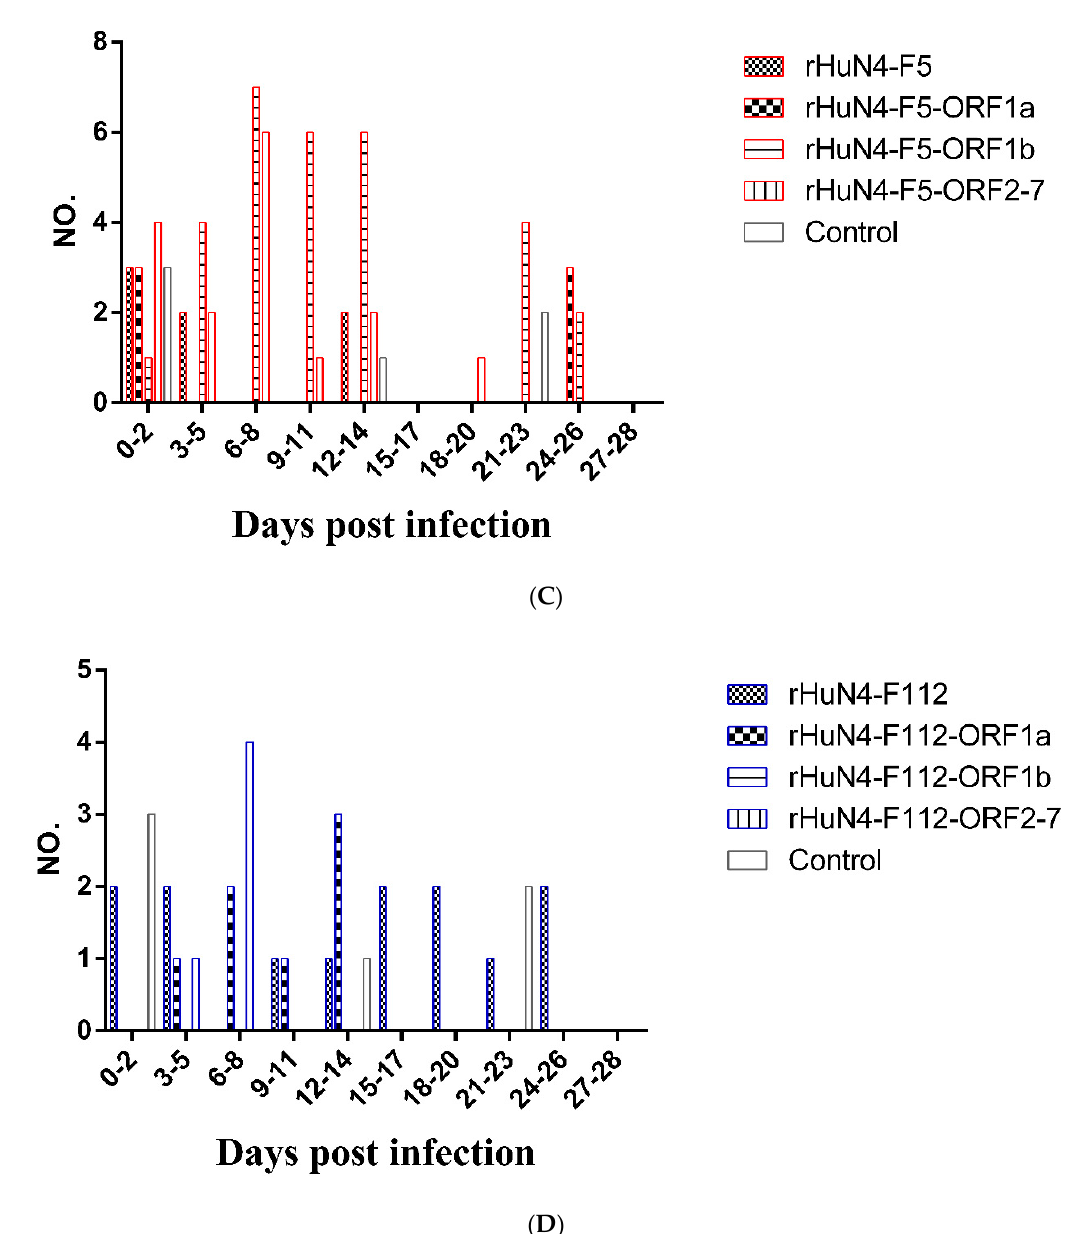
Figure 3. Rectal temperature after infection. ( A ) Mean rectal temperature of each group after infection. ( B ) Amount case of rectal temperature equal or higher than 40.5 °C of each group. ( C ) Amount case of rectal temperature higher than 40 °C and lower than 40.5 °C of groups which infected with HuN4-F5 backbone chimeric viruses. ( D ) Amount case of rectal temperature higher than 40 °C and lower than 40.5 °C of groups which infected with HuN4-F112 backbone chimeric viruses. Mean rectal temperature were presented as means ± standard deviations (error bars), “*” means p ≤ 0.5. Cases were counted every 3 days.